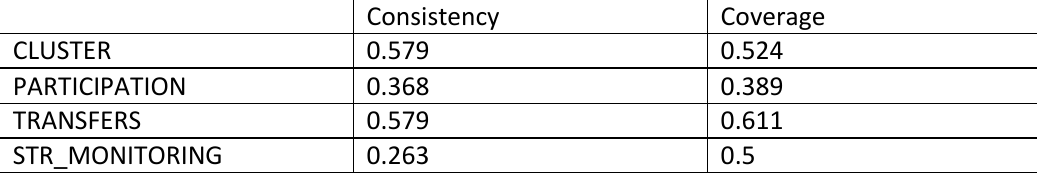
Table A2.3 Consistency and coverage scores for necessity